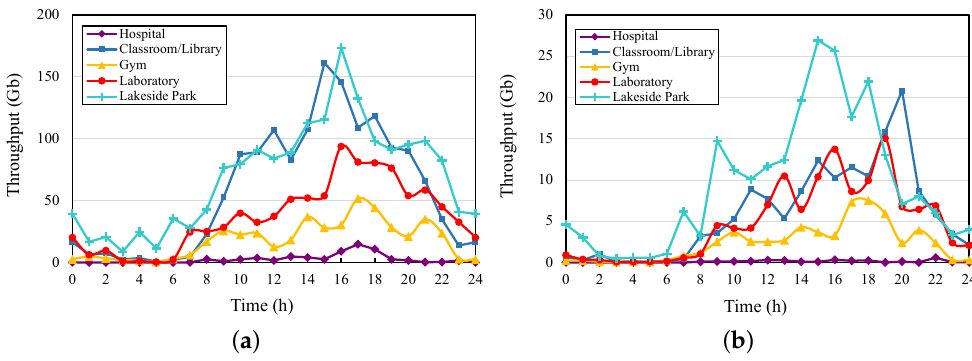
Figure 6. The total throughput of diverse base stations within one weekend (24 h). ( a ) Downlink; ( b ) uplink.